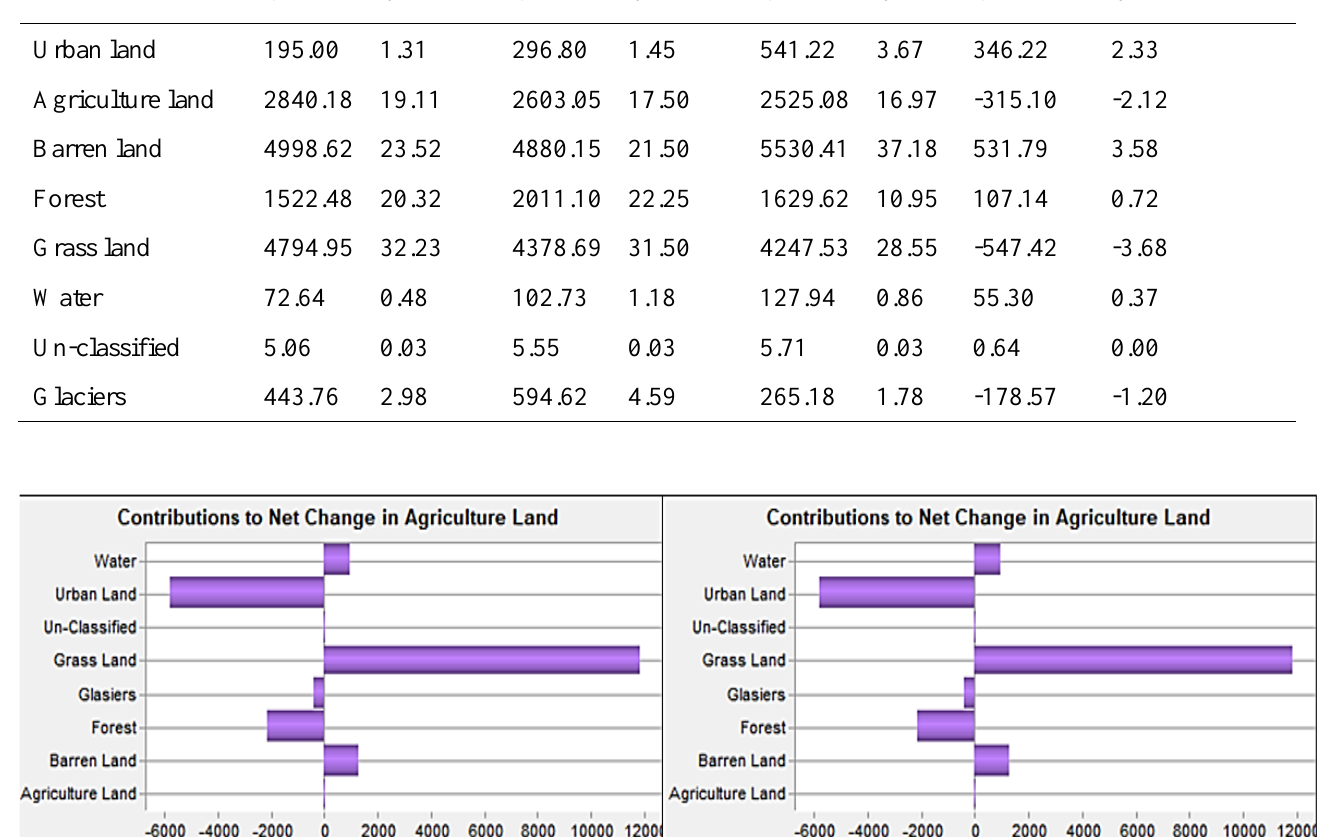
Figure 4. The land use cover class's gain and loss areas between 1990 and 2005 and 2005 and 2009